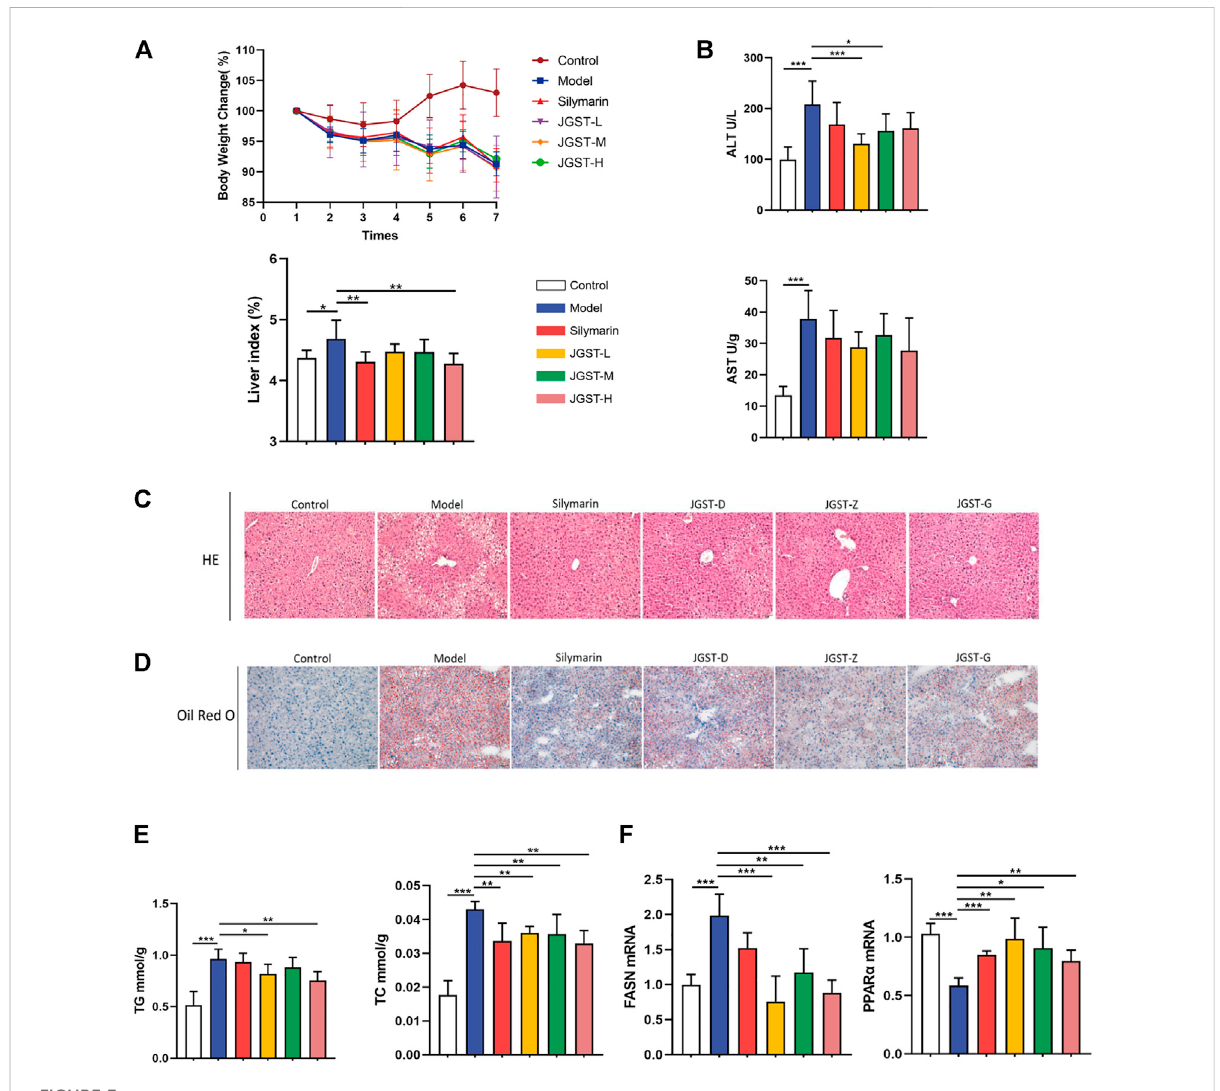
FIGURE 3 Liver protection effect for JGST againstALD induced mousemodel. (A) Mouse body weight changesand liver index. (B) Liver function enzymes ALT and AST (C) Representative photomicrographs of liver tissue with H&E staining (x200, 50 p.m., n = 6). (D) Representative photomicrographs of liver tissue with oil red O staining (x 200, 50 p.m., n = 6). (E) Liver level of cytoplasmic TG and TC. (F) mRNA expression of PPARa and FASN in liver tissues. Control: normal control group, Model: model group, Silymarin: silymarin-positive group, JGST-L: the low-dose group of JGST;